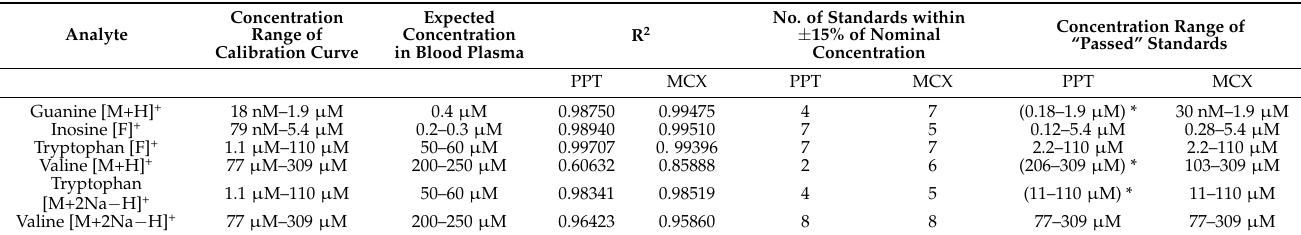
Table 1. Summary of results from the calibration curves. Tryptophan and inosine were detected as fragments due to extensive in-source fragmentation which is noted as [F] + . * The calibration range contains too few “passed” calibration standards for a linear range to be